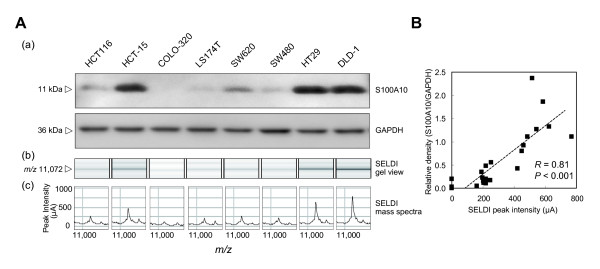
Comparison of Western blot densitometry and SELDI peak intensity. (A) A Western blot illustrating the differential expression of S100A10 derived from cell lysates of 8 CRC cell lines (a). SELDI-TOF MS gel view (b) and mass peak (c) illustrating the differential expression of the protein at m/z 11,072 in cell lysates from 8 CRC cell lines. The results are representative of three separate experiments. (B) The results of Western blot densitometry of S100A10 significantly correlated with the SELDI peak intensity at m/z 11,072. Twenty-four experimental data points (3 separate experiments with each of 8 cell lines) are plotted.